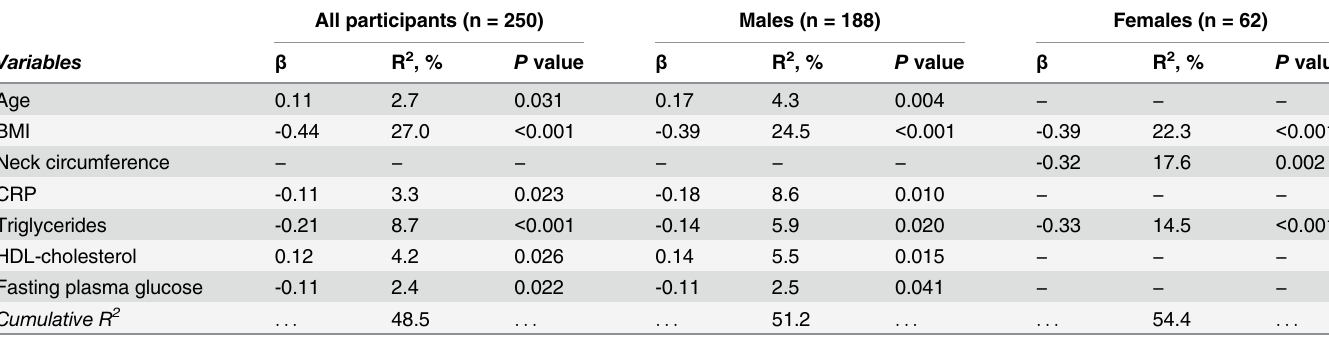
Table 3. Stepwise multiple regression models for CT LFA.